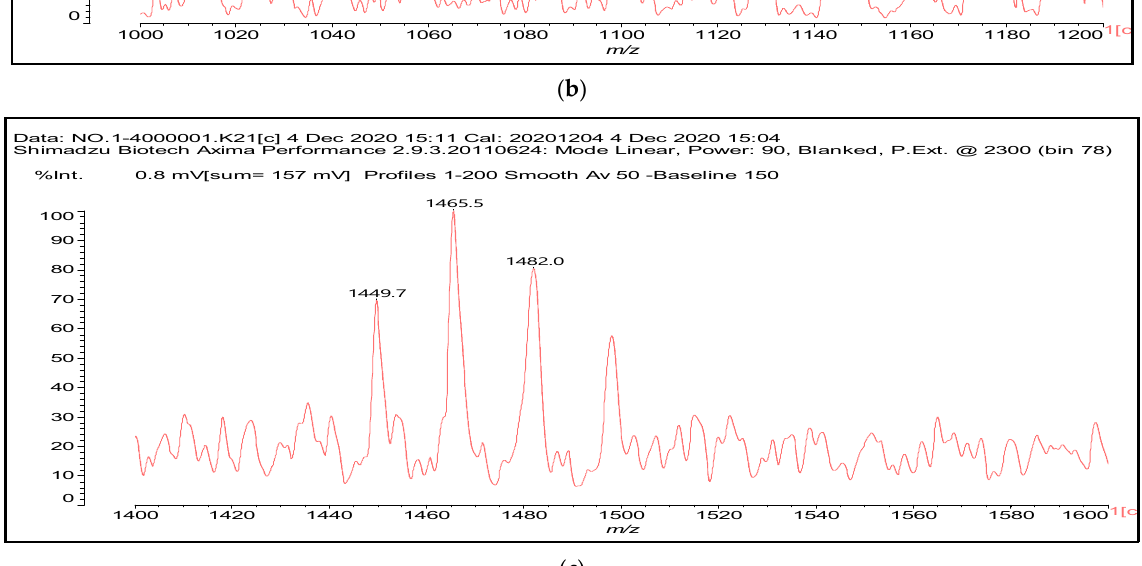
Figure 5. MALDI ToF spectra of SPI–quebracho tannin extract adhesive: ( a ) 400–1000 Da range; ( b) 1000 Da–1200 Da range; ( c ) 1400–1600 Da range. An example of species not contributing to the cross-linking of the protein by the tan- nin are the species represented by the peaks at 614–615 Da (with no Na + ) and 640–642 Da (with Na + ). The species ( III ) forms, but by reacting with the amino groups that in the pro- tein participate in the peptide bond (Figure 6).